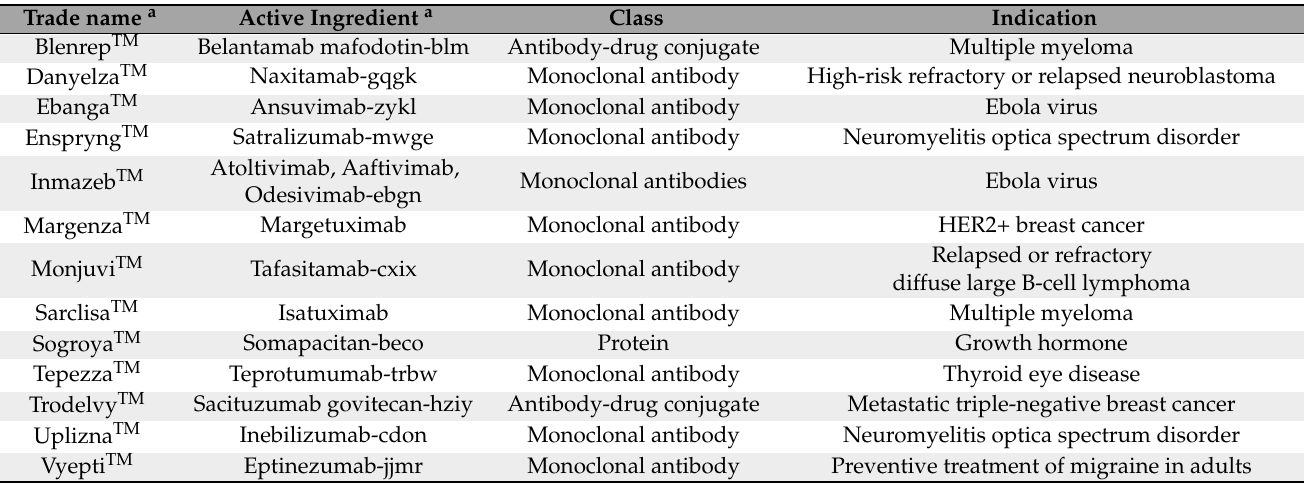
Table 1. Biologics approved by the FDA in 2020